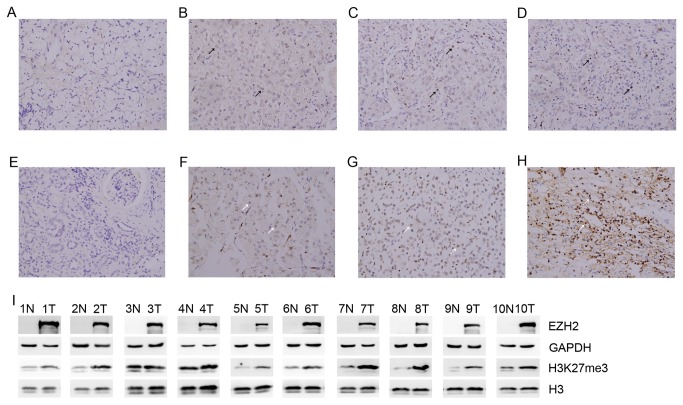
The expression of EZH2 and H3K27me3 in human samples.Representative EZH2 and H3K27me3 immunohistochemical staining in renal cell carcinoma (200×magnification). (A-H) Positive EZH2 (black arrow) and H3K27me3 (white arrow) display a nuclear staining. (A) negative in RCC (E) negative in none tumor tissue (B-D) EZH2 positive (F-H) H3K27me3 positive (B) (F) staining intensity index-1socre (C) (G) staining intensity index-2 score (D) (H) staining intensity index-3 score (I) the expression of EZH2 and H3K27me3 was detected in all 10 cases of RCC tissues compared to adjacent non-RCC tissues. N, non-RCC tissue; T, RCC tissue.